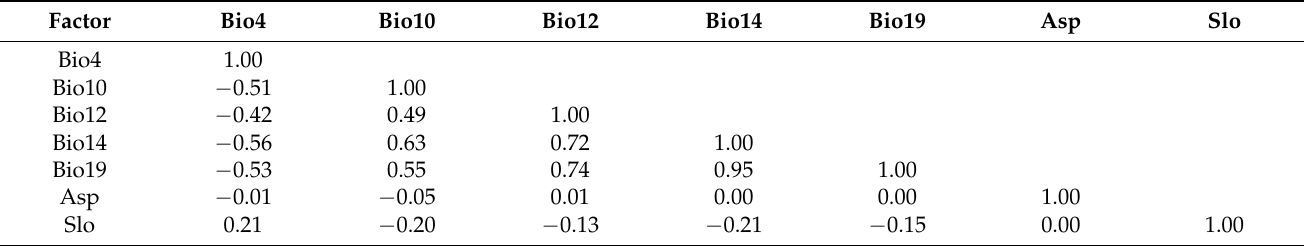
Table A2. Multi-collinearity test by utilizing correlations among climate variables for R. rex subsp. rex . Factor